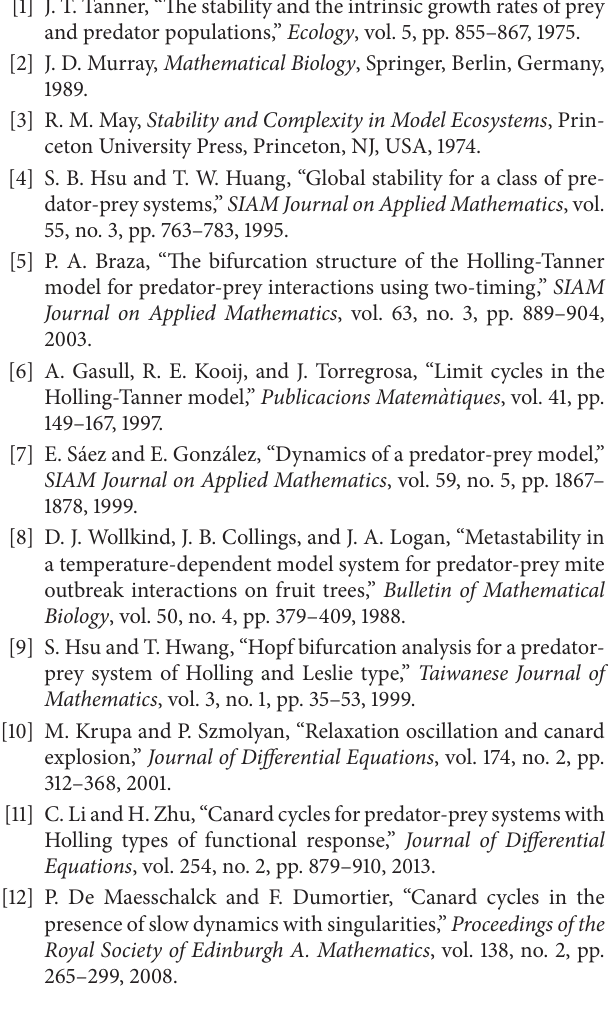
𝜖 = 0.005 , and 𝜆 = 0.001 (see Figure 2), in which Figures 2(b) and 2(c) illustrate the existence of the fast stages of 𝑥 = 𝑥(𝑡) and 𝑦 = 𝑦(𝑡)